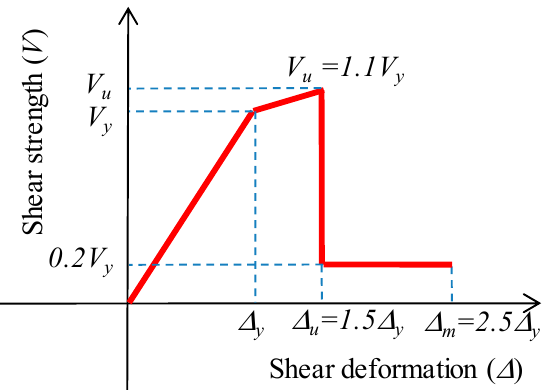
Figure 2. Shear force–deformation relationship of the cross section.